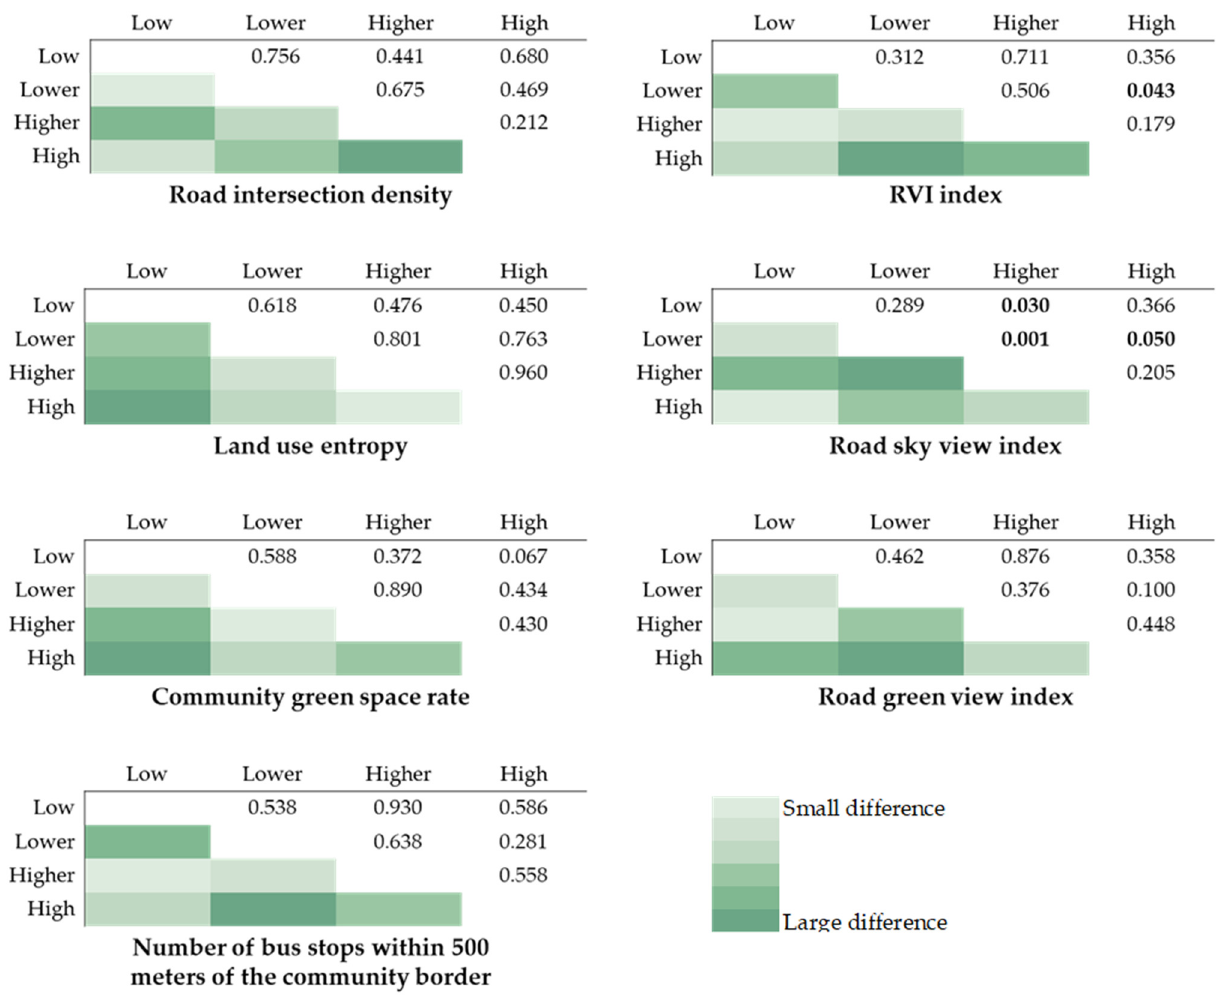
Figure 4. Multiple tests between each level in the built environment.